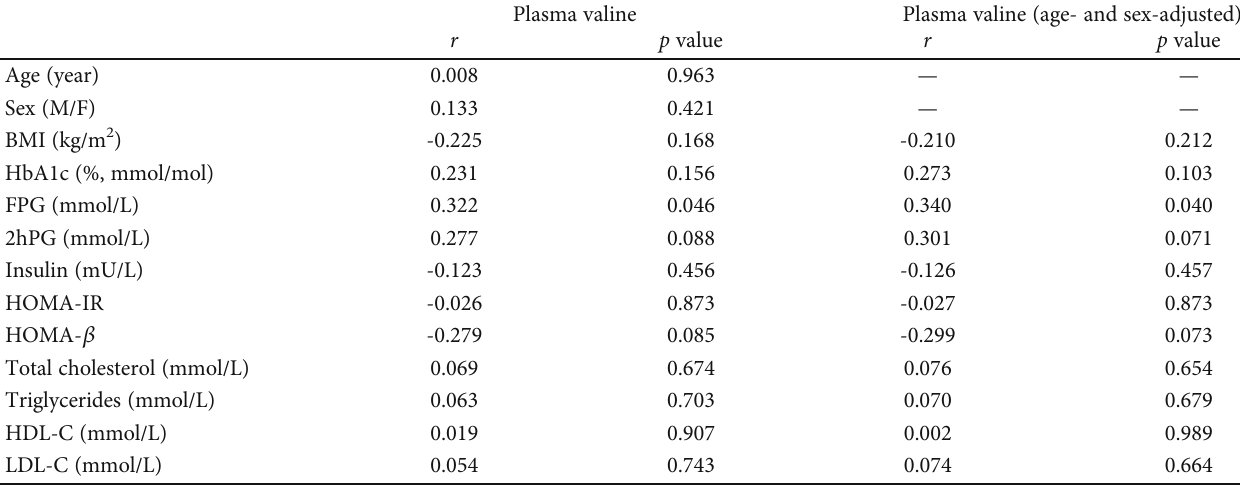
Table 2: Correlation coe ffi cient of clinical characteristics associated with plasma valine concentration in the study